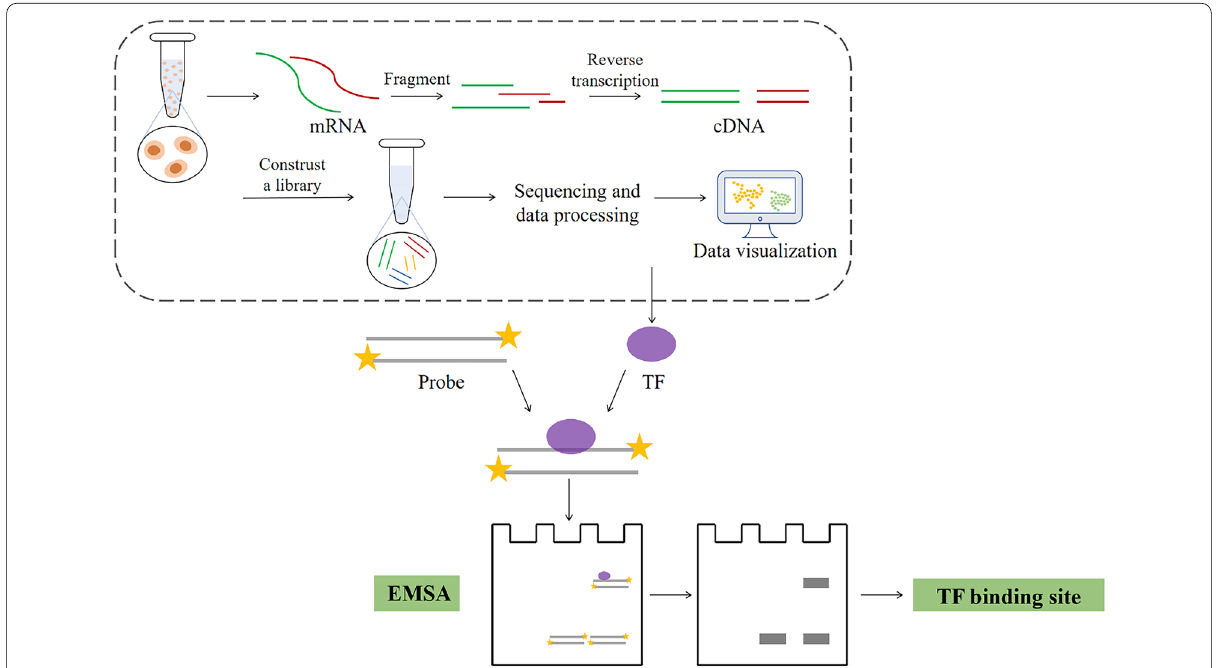
Fig. 1 Mining strategy of TFs and identification of TFs binding